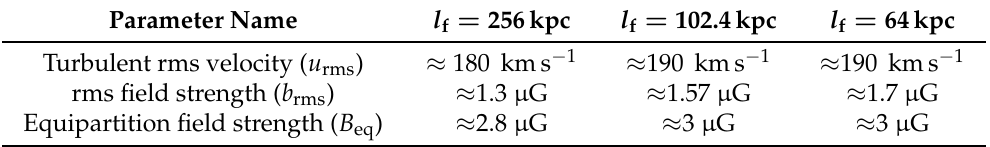
Table 2. The rms values of the turbulent velocity u rms , the magnetic field b rms and the equipartition field strength B eq from simulations at three different turbulent driving scales. The simulation domain is 512 512 512kpc 3 with a resolution of 1 × ×